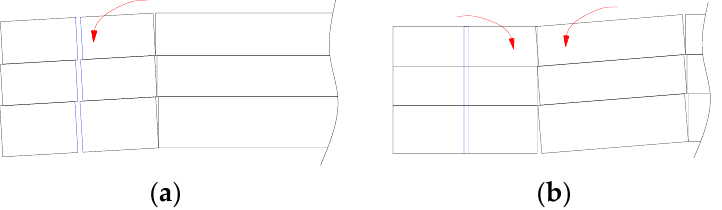
Figure 11. Borehole dislocation and recovery: ( a ) dislocation due to block rotation; ( b ) dislocation recovery due to the reverse rotation of the block.